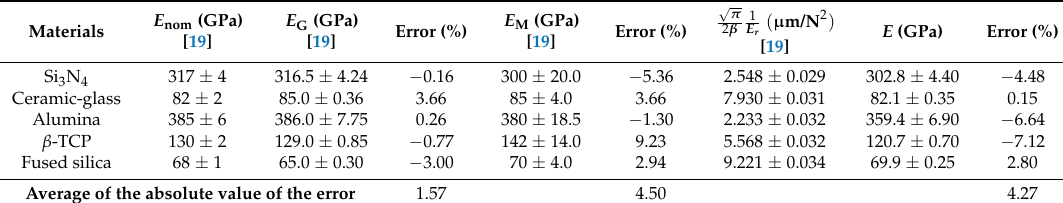
Table 5. Experimental Young’s modulus